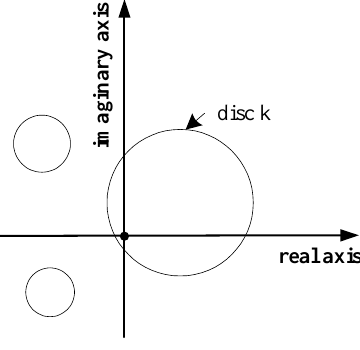
Figure 2. Schematic of the limitation of the basic Gersgorin theorem.